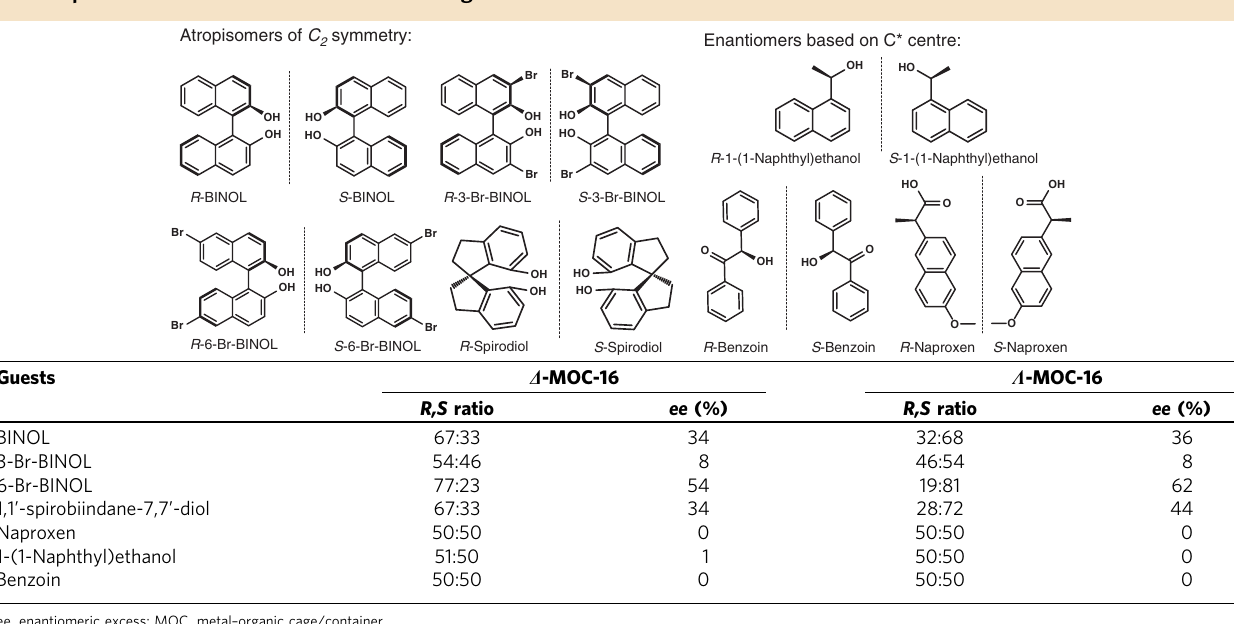
Table 1 | Enantioselective resolution of chiral organic